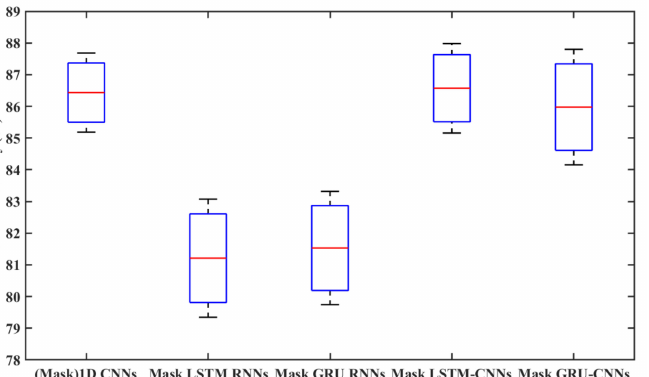
Figure 7. Average overall accuracies and standard deviations (over five different random splits) of five deep learning models using unfilled Sentinel-2 time series